Question: In one sentence, what is this figure communicating?
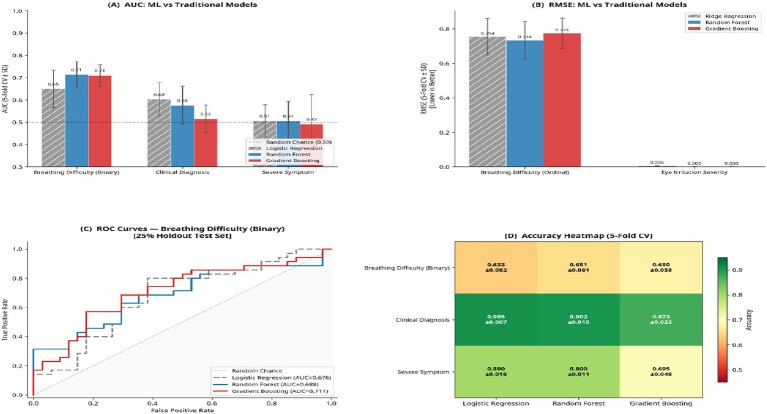
Answer: Model Performance Comparison. (A) Area under the curve (AUC) comparison between traditional and machine learning models. (B) Root mean squared error (RMSE) comparison between traditional and machine learning models. (C) Receiver operating characteristic (ROC) curves for breathing difficulty prediction. (D) Accuracy heatmap from 5-fold cross-validation across model types and health outcomes.